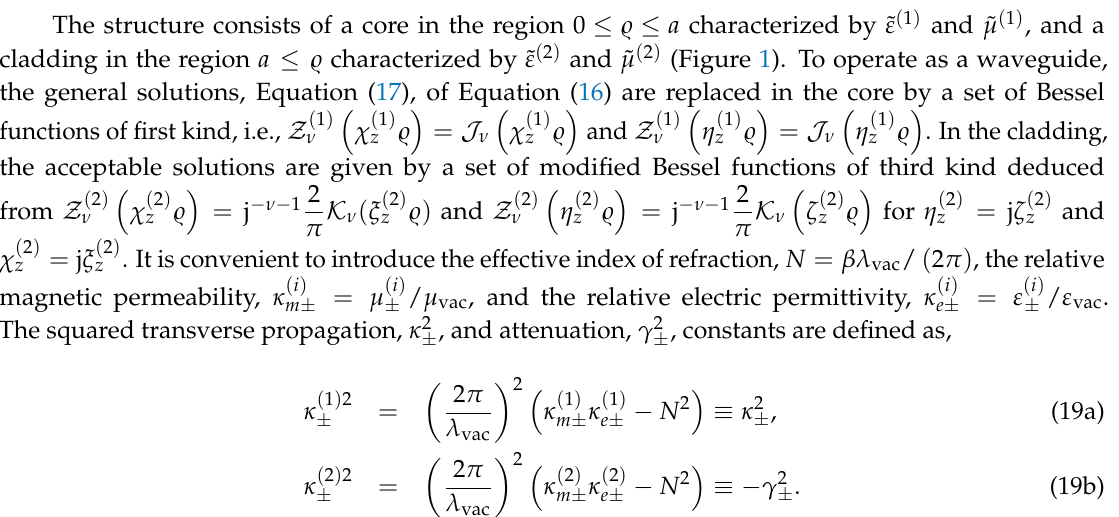
a , is characterized by the permeability and permittivity ≤ a , is characterized by the permeability and permittivity ≥